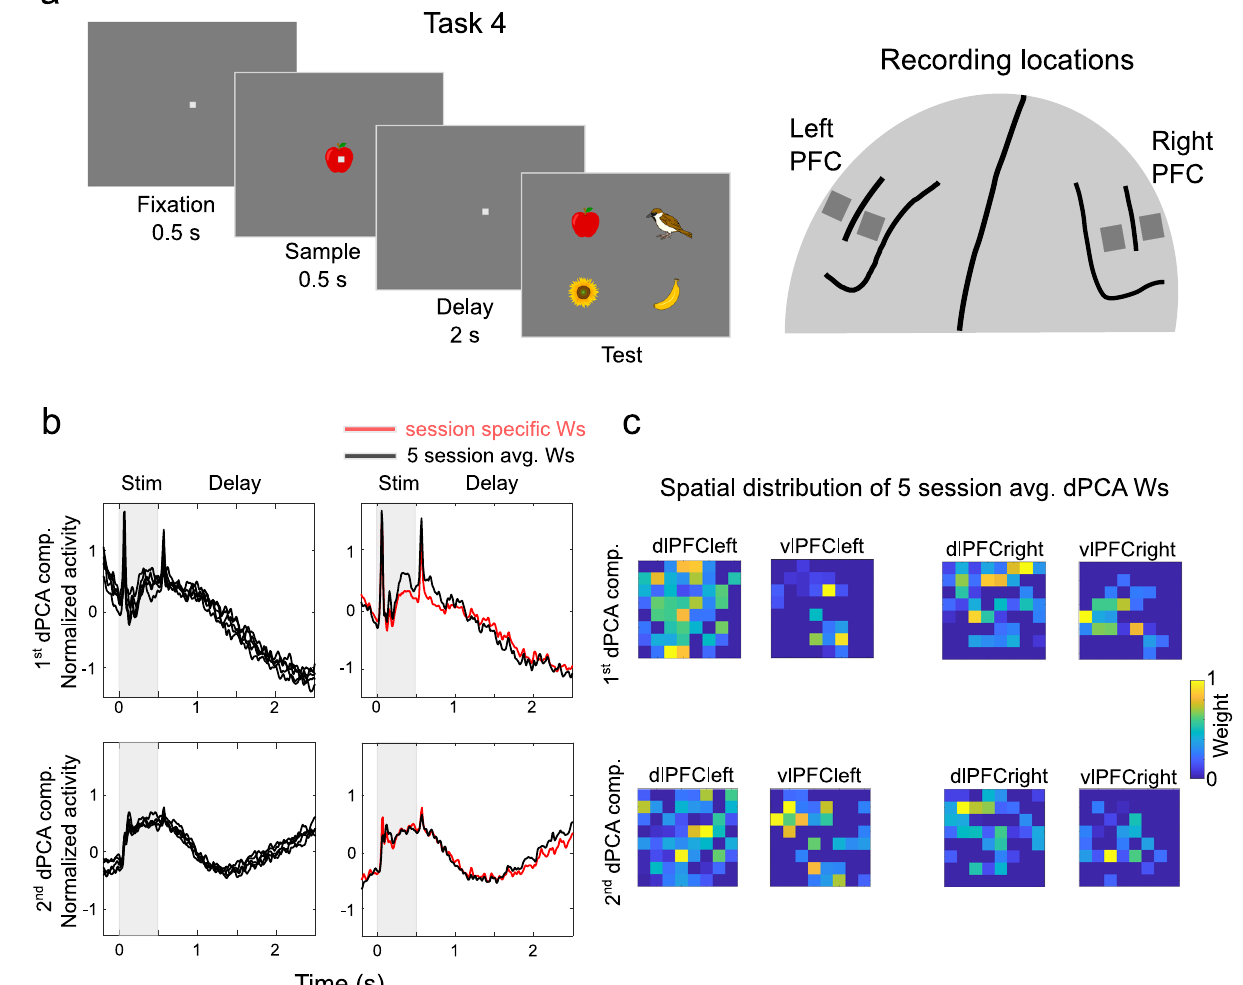
Fig. 4 | Spatial patterns of control-related activity in a delay-match-to-sample task. a Left: Schematic depiction of the delayed match-to-sample task. Right: schematic depiction of the recording locations of the four chronically implanted Utah arrays (left and right dlPFC, left and right vlPFC). b Left: the fi rst (top) and second (bottom) task-general dPCA components of gamma activity projected usingthe fi ve-sessionaveragedPCAweightvectorsforeachoneofthe fi vesessions. Right: plotted are the fi ve-session averages of the fi rst and second task-general